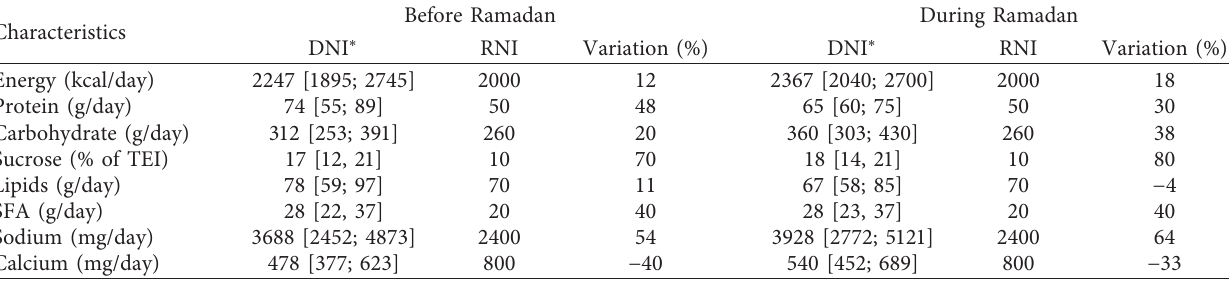
Table 3: Rate of variation in DNI according to RNI ( n � 340).